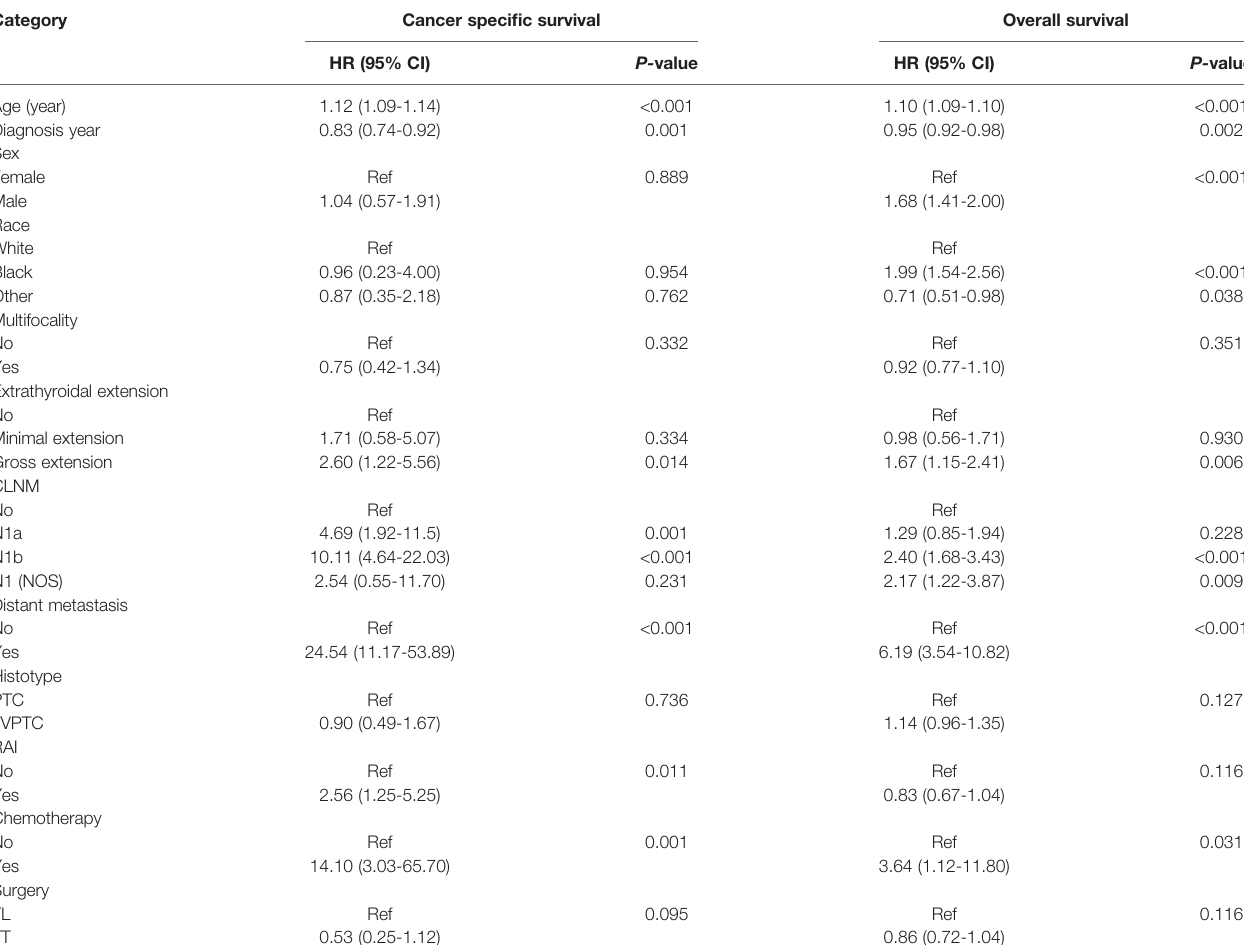
TABLE 2 | The predictors for CSS and OS of PTMC patients by multivariate Cox